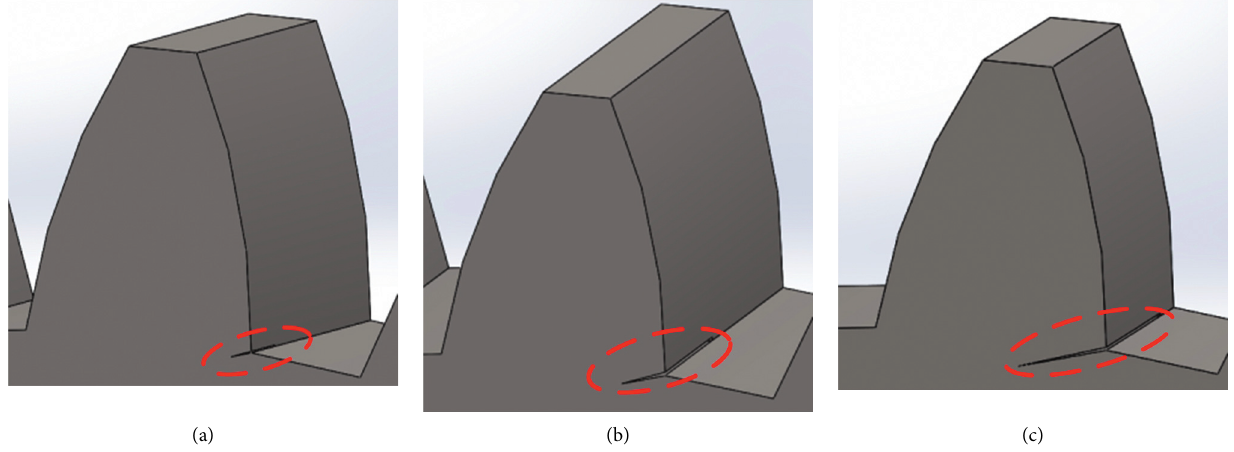
Figure 4: 3D crack model of sun gear. (a) 1 # crack. (b) 2 # crack. (c) 3 # crack.